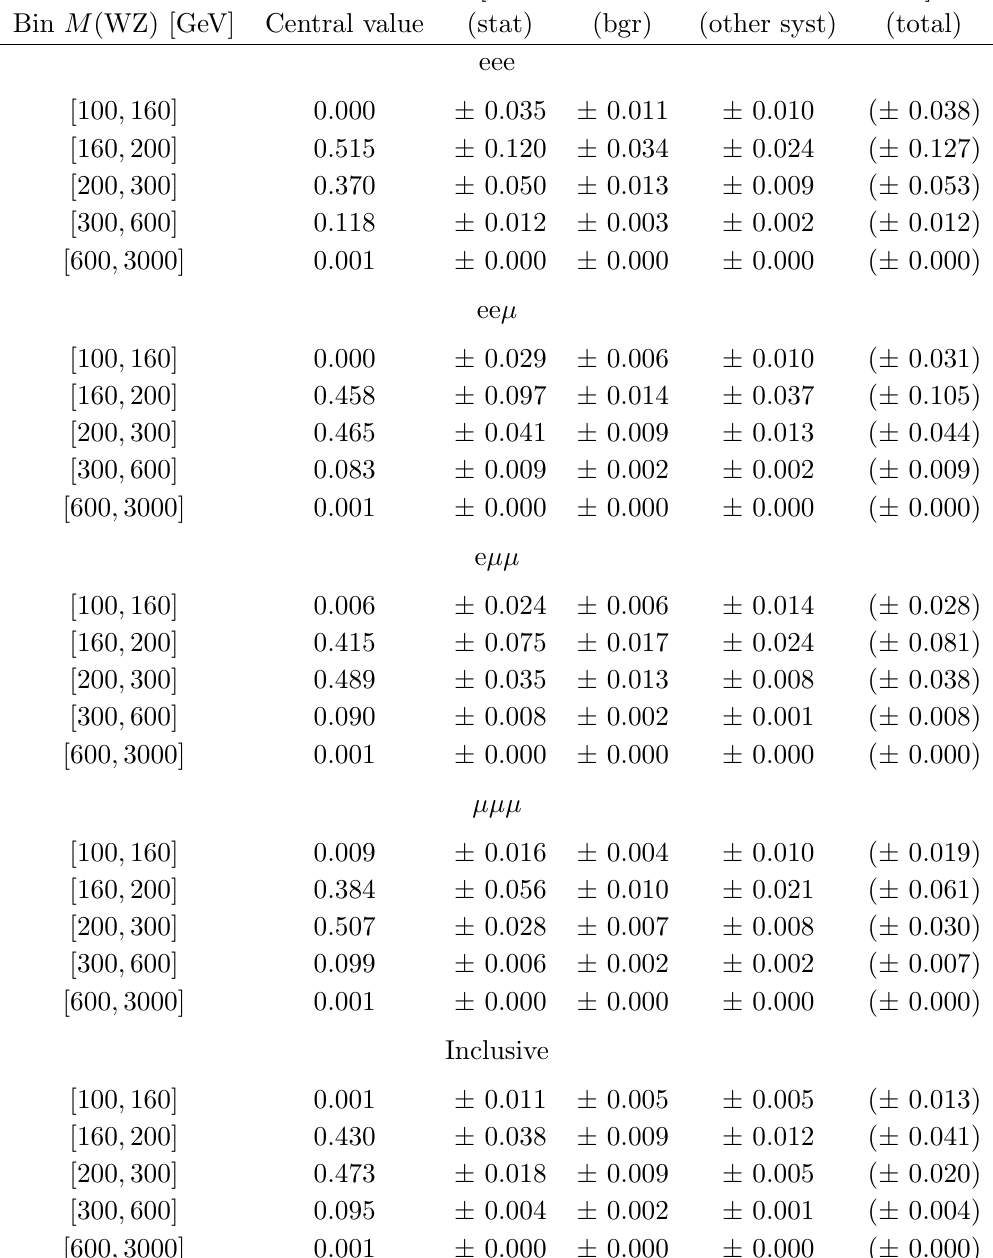
Table 12 . Di(cid:11)erential cross section in bins of mass of the WZ system. Values are expressed as a fraction of the total cross